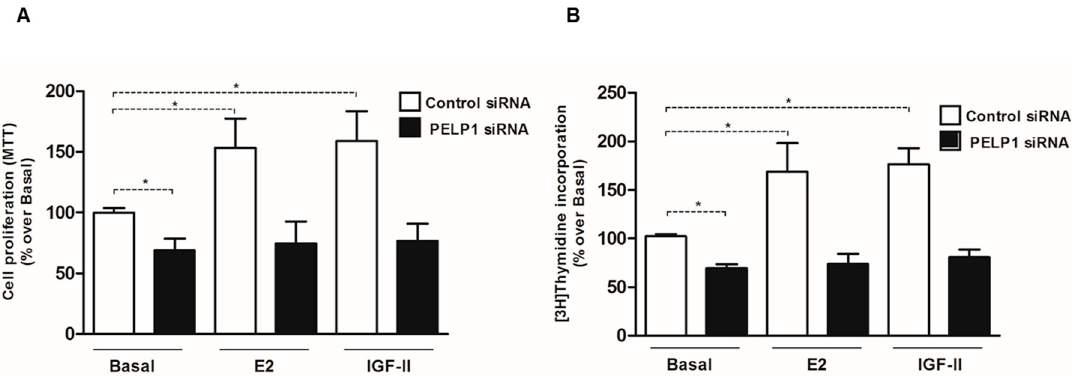
Figure 6. PELP1 knockdown reduces cell proliferation in H295R. ( A , B ), H295R cells were transfected with PELP1 siRNA or a non-targeting siRNA (control siRNA). Twenty-four hours after silencing, cells were left untreated (Basal) or treated for an additional 48 h with IGF-II (100 ng/mL) or E2 (100 nM). (* p < 0.0001 compared with Basal). At the end of the experiment, cells were incubated with MTT ( A ) or [3H] thymidine ( B ) as described in Materials and Methods.